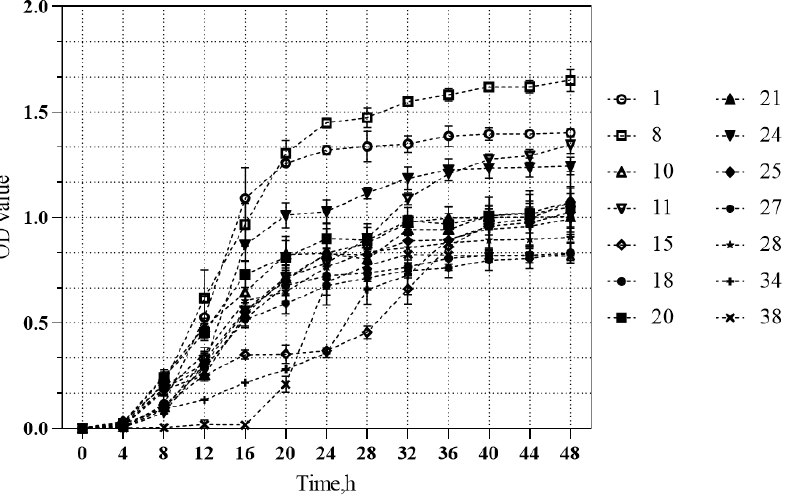
Figure 1. Growth curves of 14 rumen-derived yeast strains incubated for 48 h at 39 °C and 150 rmp in a culture-shaker under aerobic conditions.